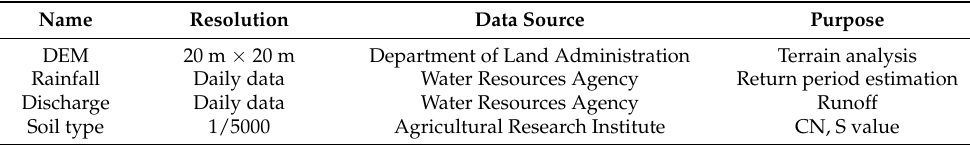
Table 1. Related information used in the study.